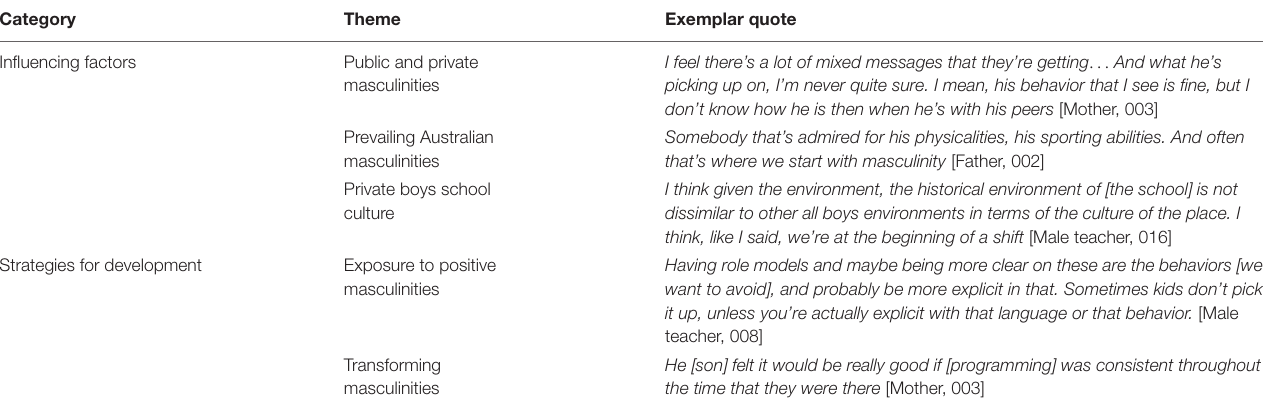
TABLE 2 | Summary of themes with exemplar